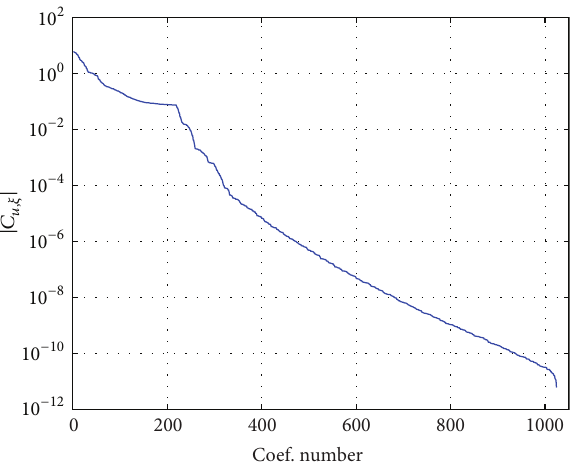
Figure 2: This figure shows frame coefficients |𝐶 𝑗,𝑘 | (sorted) for 𝑓 = exp (𝑖𝜙(𝑥)) where 𝜙(𝑥) = −𝑥 2 + 𝑥 . Here we have considered 64 window functions with 128 grid points on each